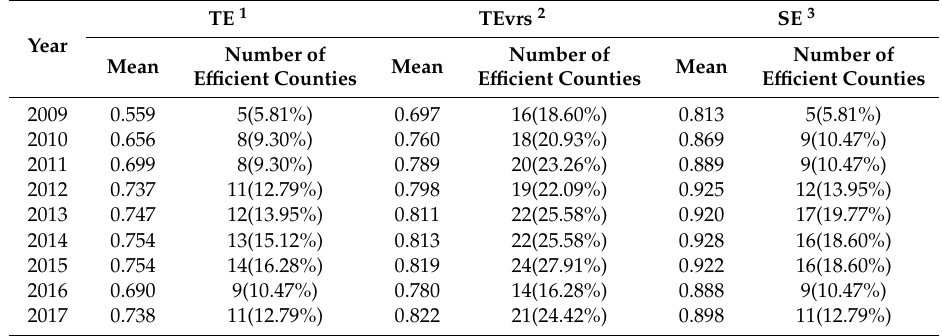
Table 3. The e ffi ciency of Primary Health Care Institutions (PHCIs) in the counties of Hunan Province from 2009 to 2017 (input-oriented Banker, Charnes and Cooper (BCC) model).